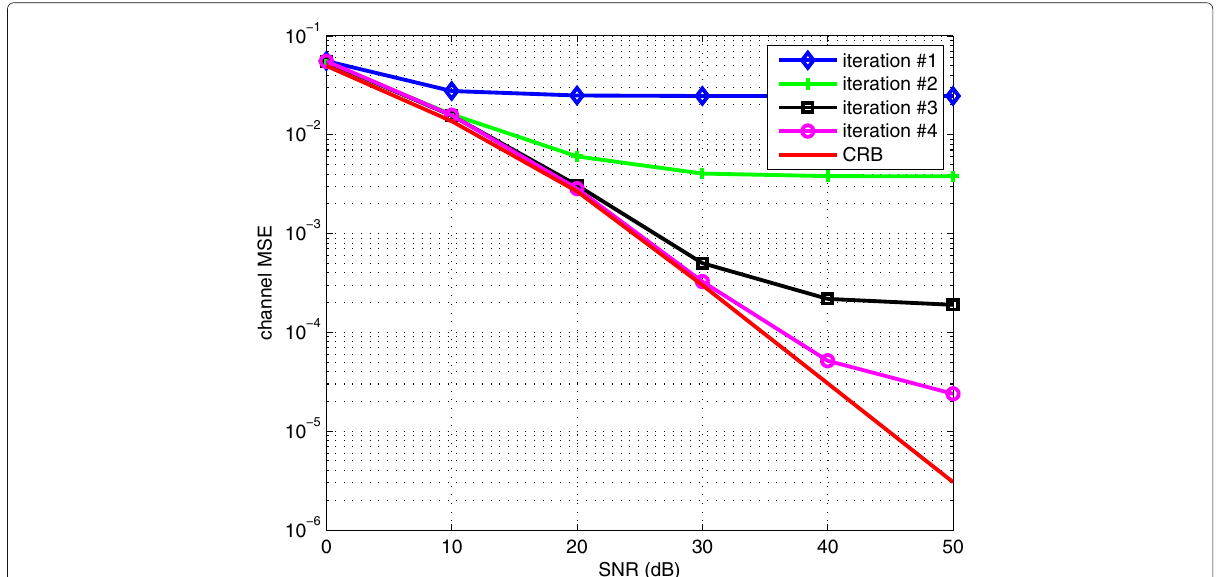
Fig. 3 Performance of the CML estimator as a function of the SNR for SIR = − 5 dB, K =